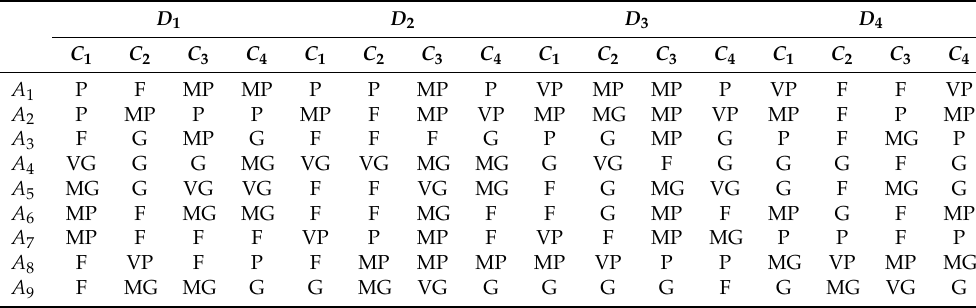
Table 2. The decision-matrix of each decision-maker at first period ( t = 1).